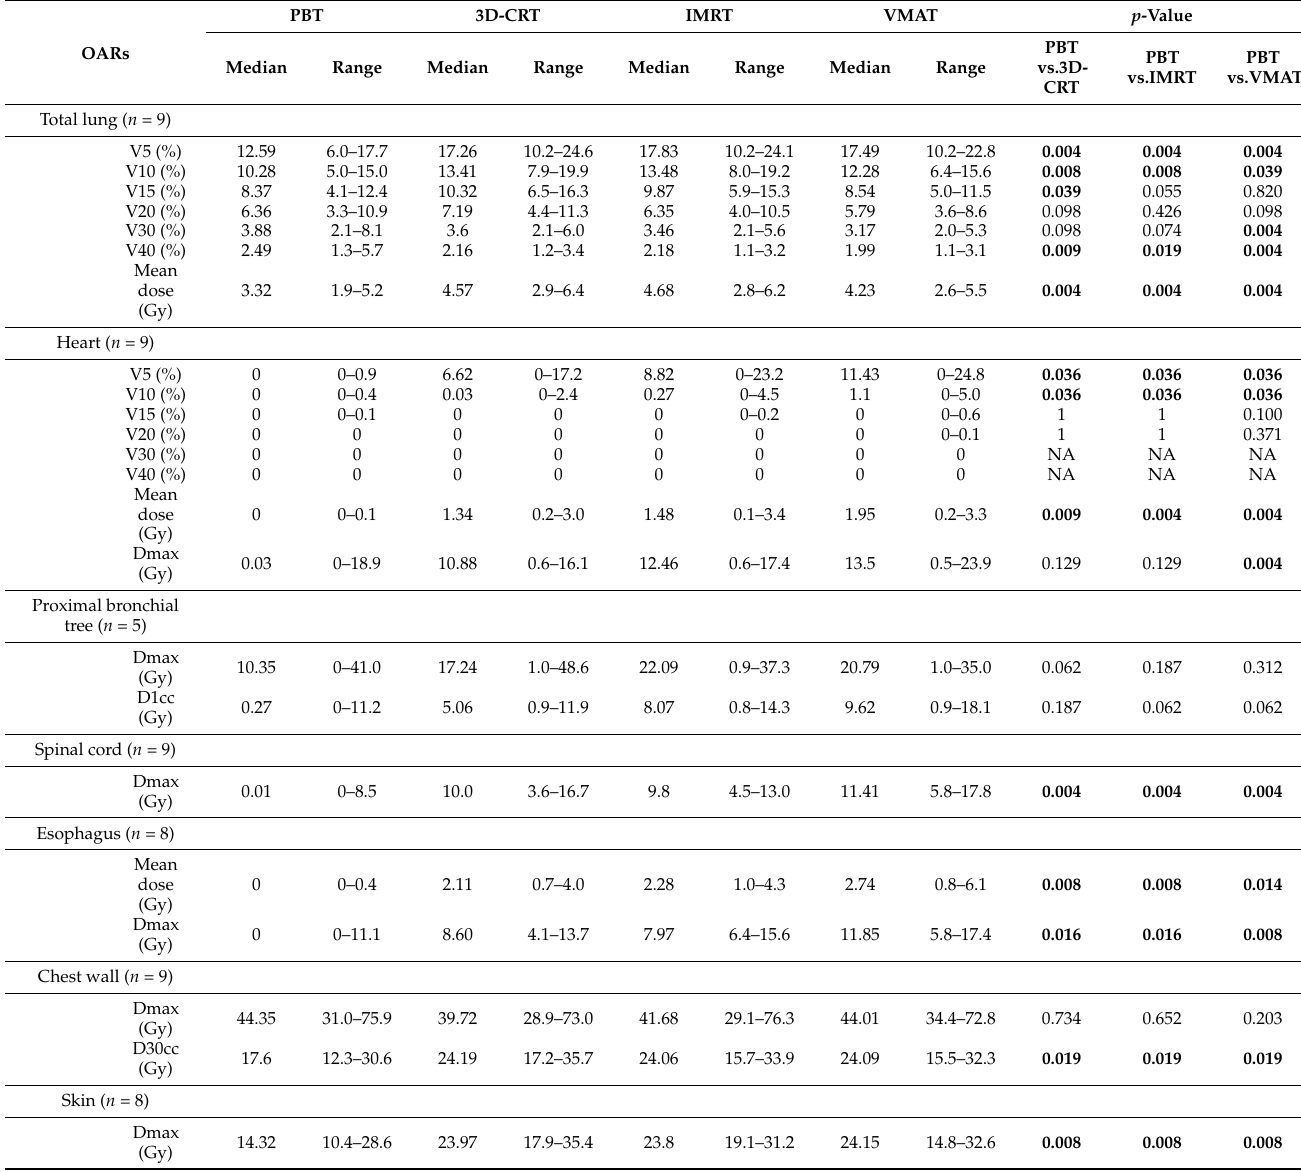
Table 3. Summary and comparison of the dosimetric parameters of peripherally located tumors (60 CGE/4 fx = 9).